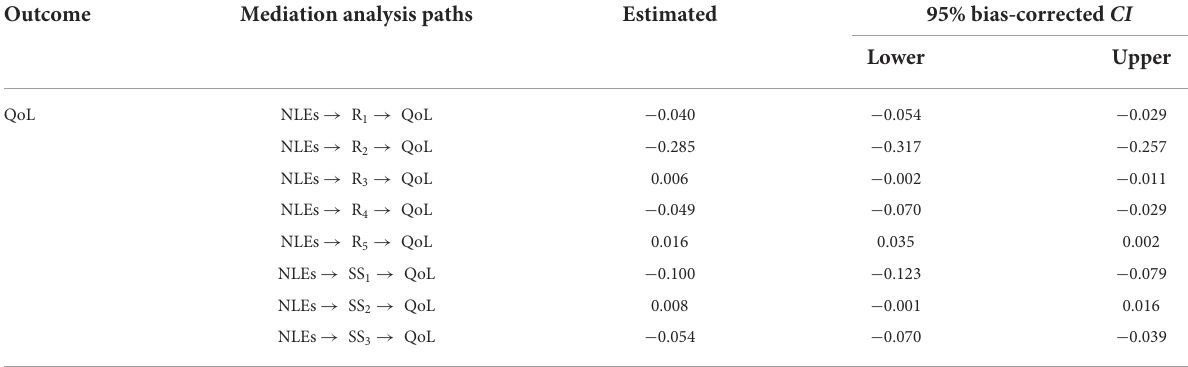
TABLE 4 The mediating effect of NLEs on quality of life through various dimensions of R and SS.